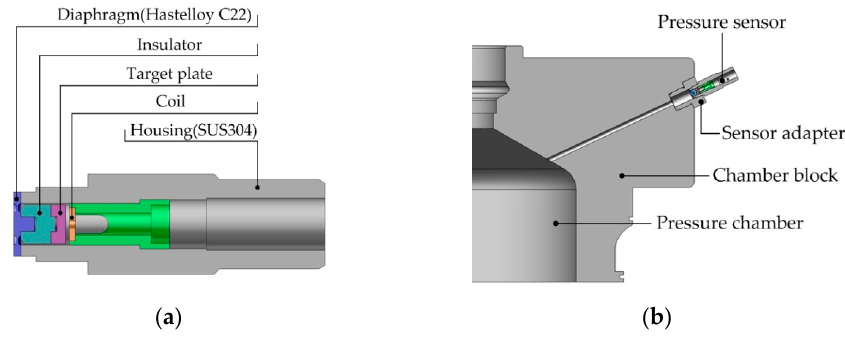
Figure 1. Eddy current type pressure sensor: ( a ) structure; ( b ) on site application.